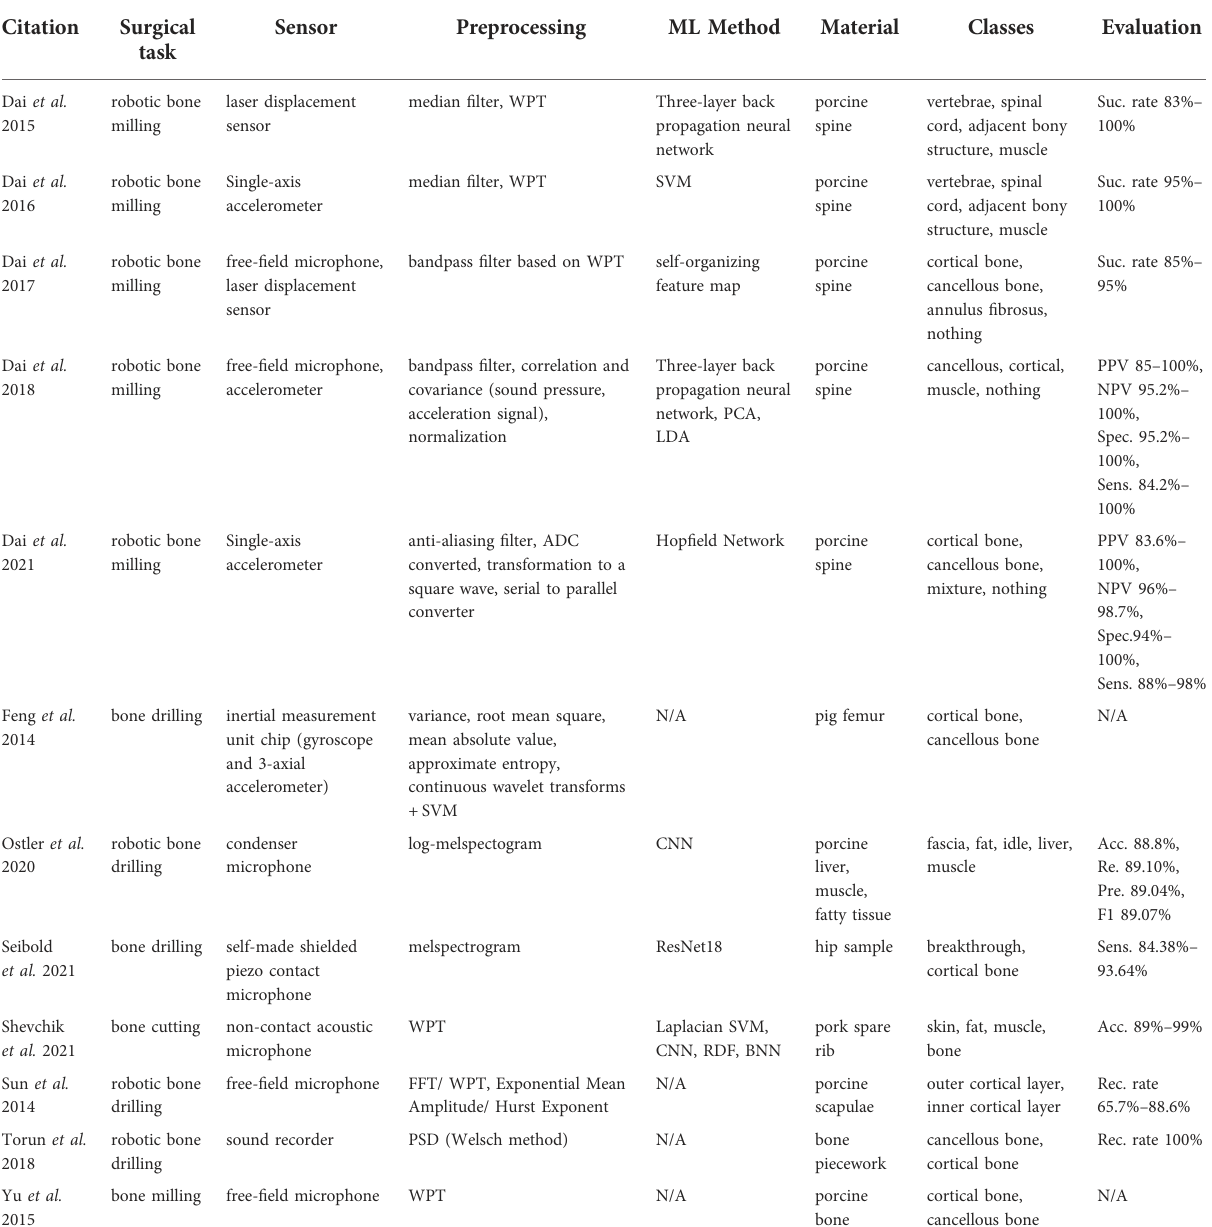
TABLE 6 General description of selected paper related to vibro-acoustic